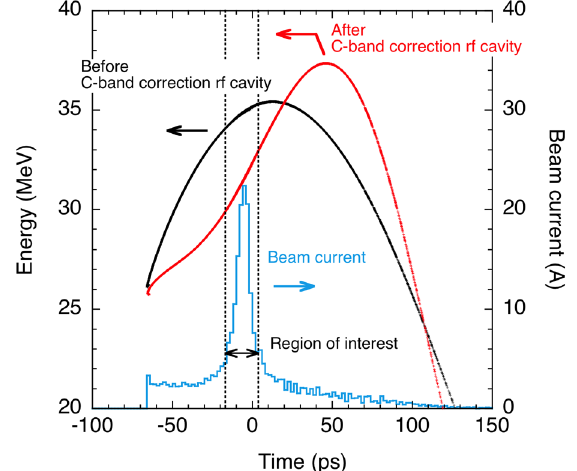
FIG. 4. Energy profile (black and red dots) and beam current (blue line) as functions of the bunch longitudinal position (time), simulated using PARMELA. The left side corresponds to the bunch head. The black and red dots correspond to the locations before and after the C-band correction rf cavity,